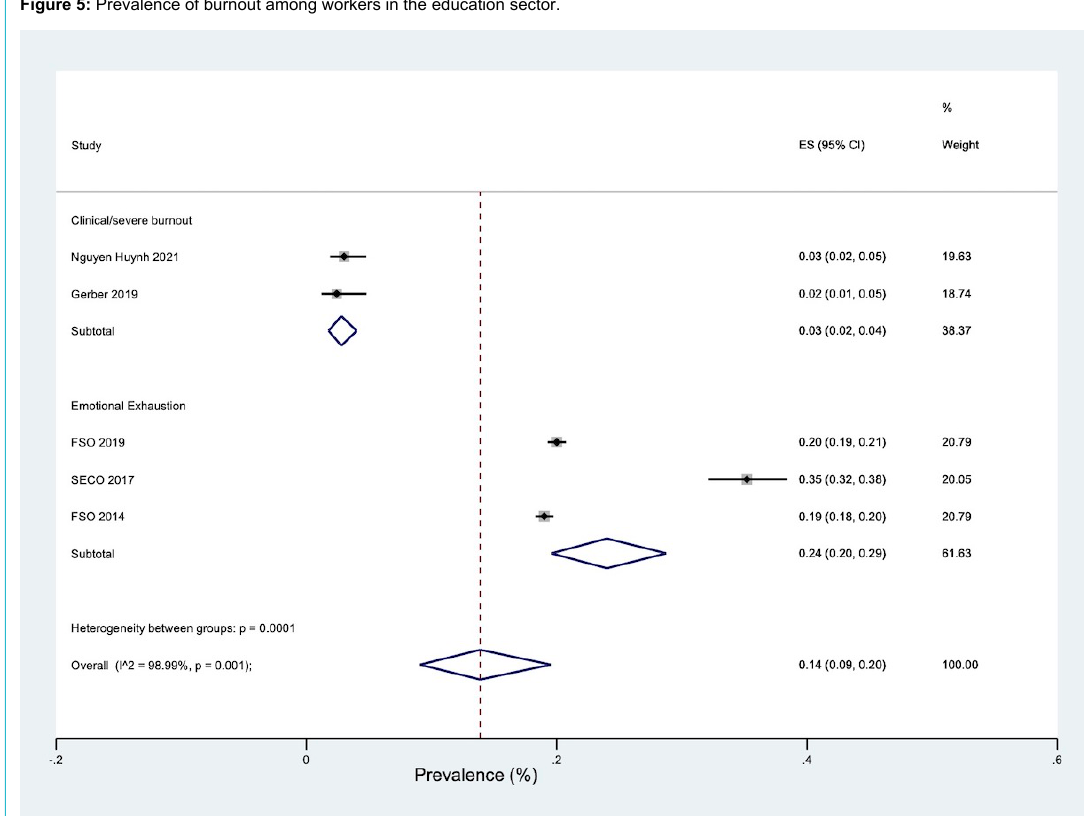
Figure 5: Prevalence of burnout among workers in the education